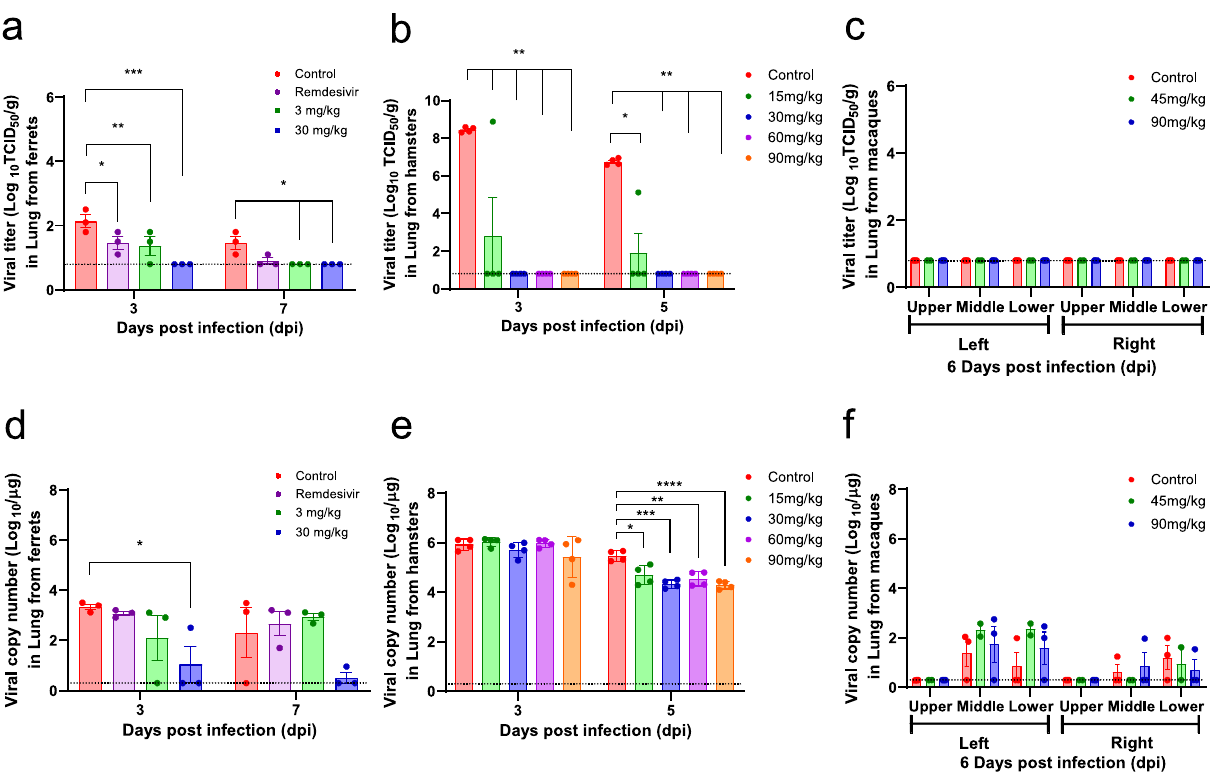
Fig. 4 Virus titration and quantitation in the lower respiratory tract of animal models. Three ferrets per group were euthanized at 3 and 7 dpi, and lungs were collected to measure viral titers ( a ) and the number of viral RNA copies ( d ). Golden Syrian hamsters ( n = 12/group) were challenged intranasally with 6.4 × 10 4 PFU/80 μ L of SARS-CoV-2. Vehicle and 15, 30, 60, and 90 mg/kg of CT-P59 were intraperitoneally administered 24 h after virus inoculation. Four animals were euthanized for virus titration ( b ) and quantitation of viral RNA copies ( e ) from each group at 3 and 5 dpi. Rhesus monkeys (control n = 3, 45 mg/kg n = 2, 90 mg/kg n = 3) were infected with 10 6.4 TCID 50 /ml of SARS-CoV-2 via in a combination of intranasal (0.5 ml), intratracheal (4 ml), ocular (0.25 ml/eye), and oral (1 ml) routes. Vehicle, 45 mg/kg and 90 mg/kg of CT-P59 were administered intravenously after 24 h of virus infection. All rhesus monkeys were euthanized at 6 dpi, and lungs were collected to measure viral titers ( c ) and the number of viral RNA copies ( f ). Viral titers in the lung were determined by TCID 50 assessment in Vero cells and viral RNA copy number measurement using qRT-PCR. Viral titers and RNA copy numbers are shown as mean value + / − SEM and titers below the limit of detection are shown as 0.8 log 10 TCID 50 /ml or 0.3 log 10 viral RNA copies/ml (dashed lines). Asterisks indicate statistical signi fi cance between the control and each group as determined by two-way ANOVA and subsequent Dunnett ’ s test. * P = 0.0309, ** P = 0.0131, and *** P < 0.0001 ( a ); * P = 0.0002 and ** P < 0.0001 ( b ); * P = 0.0329 ( d ); and * P = 0.0123, ** P = 0.0025, *** P = 0.0003,